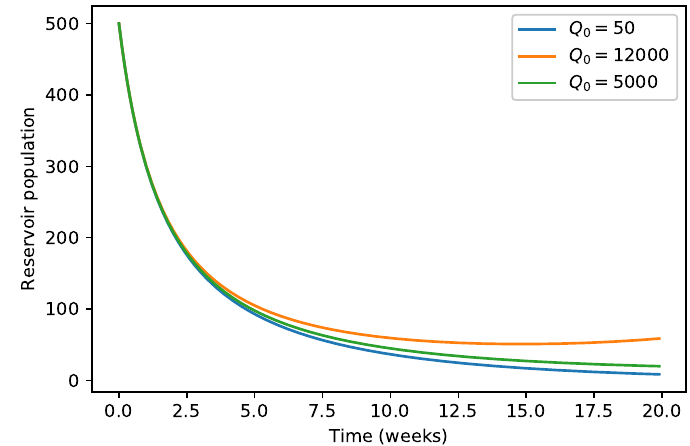
Figure 4. Variation of animals population with respect to Q 0